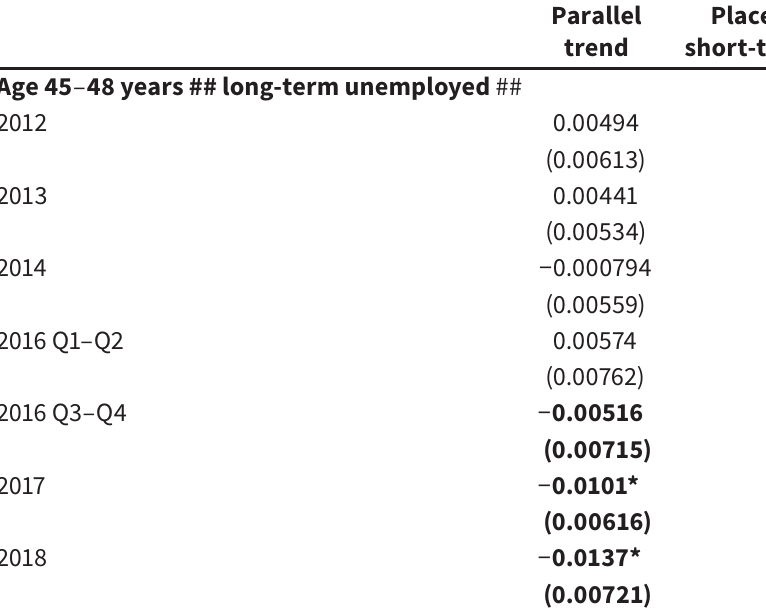
Parallel Placebo test for the trend short-term